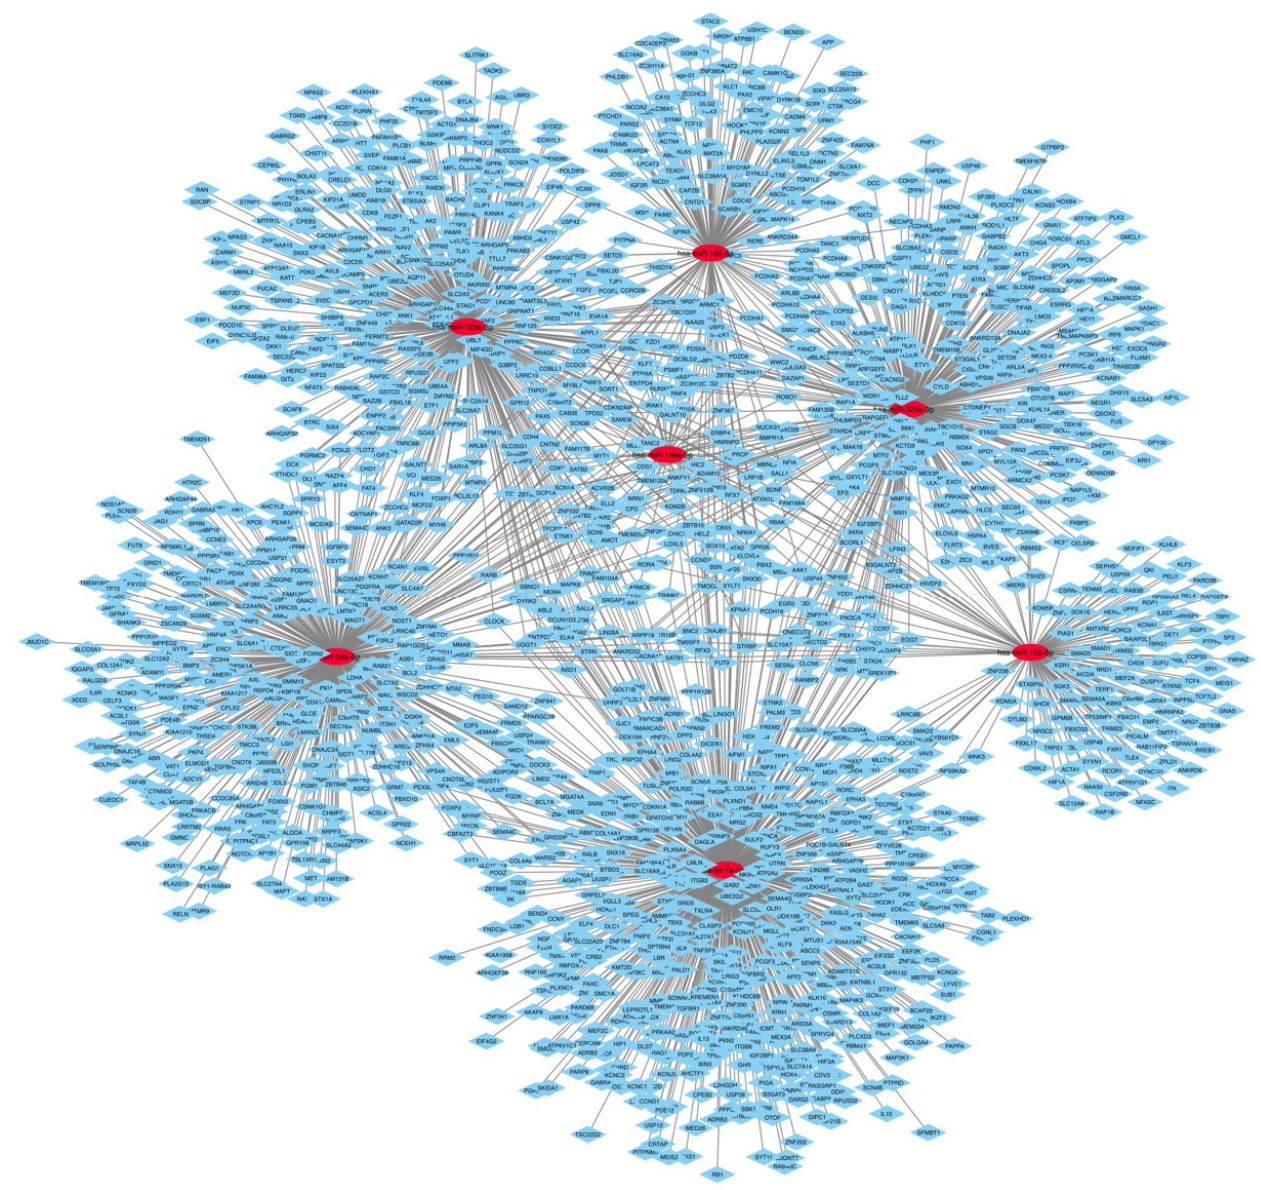
Figure 1. The miRNA–mRNA regulatory network. Red circles represent miRNAs and blue circles represent target genes.